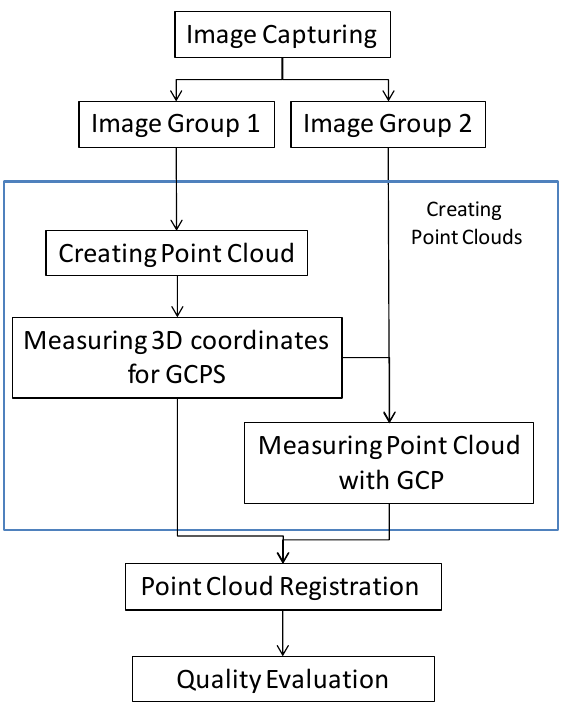
Figure 1. Procedure of the Qualification